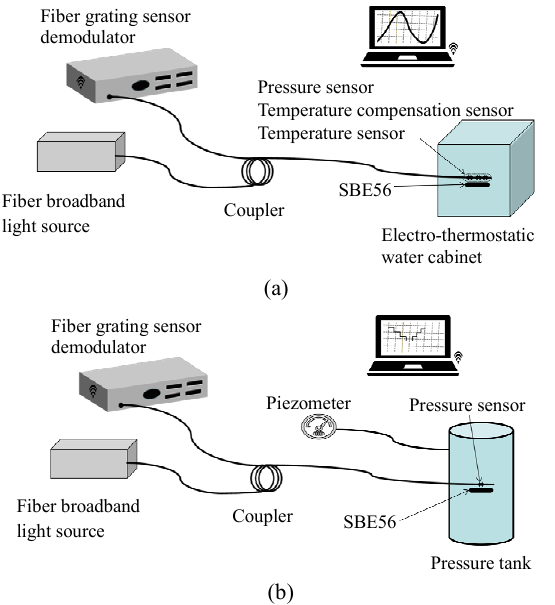
Fig. 4 Experimental setup for calibrating the (a) temperature and (b) pressure